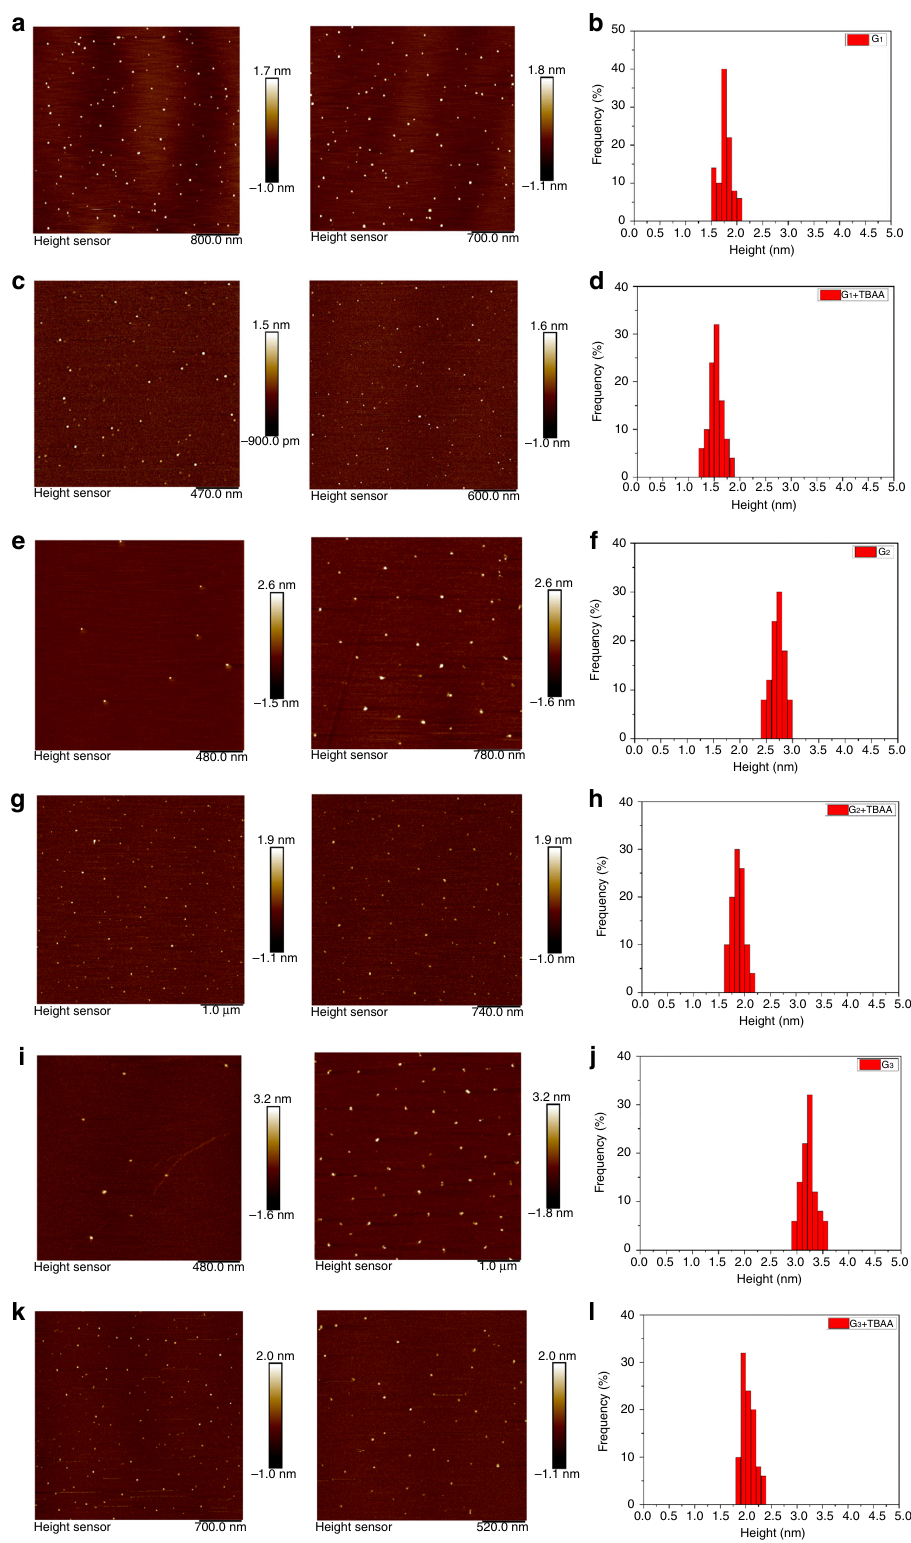
Fig. 7 AFM images of rotaxane-branched dendrimers. a G 1 ; c G 1 with the addition of TBAA; e G 2 ; g G 2 with the addition of TBAA; i G 3 ; k G 3 with the addition of TBAA; and height distributions of the rotaxane-branched dendrimers b G 1 , the height range is 1.76 ± 0.26 nm; d G 1 with the addition of TBAA and the height range is 1.52 ± 0.29nm; f G 2 , the height range is 2.70 ± 0.29 nm; h G 2 with the addition of TBAA and the height range is 1.85 ± 0.25 nm; j G 3 , the height range is 3.21 ± 0.34 nm; l G 3 with the addition of TBAA and the height range is 2.05 ± 0.30